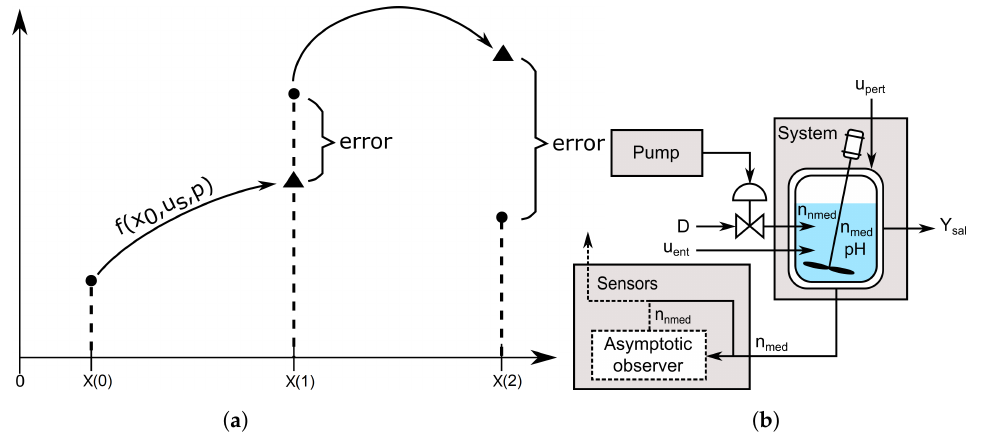
Figure 4. The proposed structures in the anaerobic digestion process. ( a ) step-ahead algorithm; ( b ) asymptotic observer